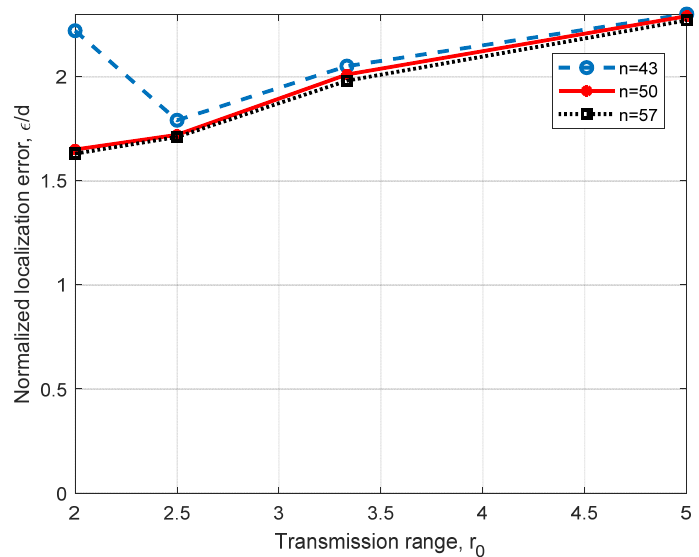
Figure 7. Error analysis for different numbers of nodes n in the network and different transmission ranges, r 0 , using four ANs in a 3D scenario, with d = 10 m.